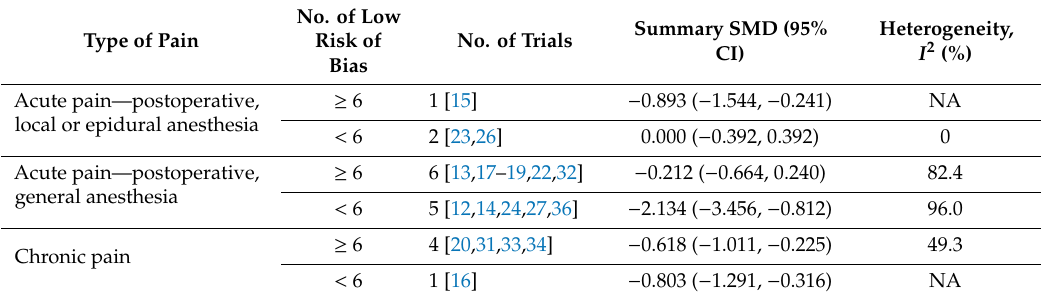
Table 3. Use of melatonin and pain score change in the subgroup meta-analysis of randomized, double-blind, placebo-controlled trials.